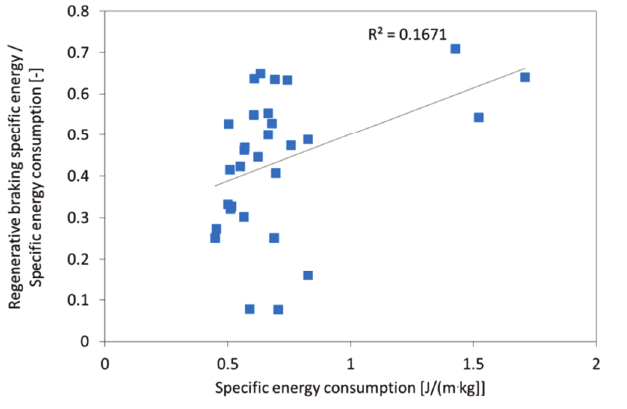
Fig. 7. Relation between the specific energy consumption and the share of the regenerative braking specific